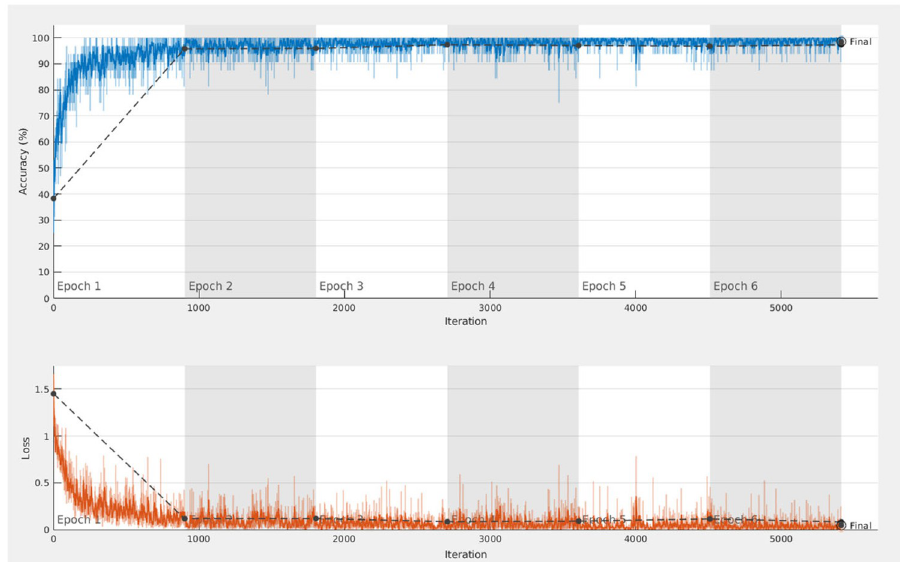
Fig 2. The training progress during fine-tuning as reported in [9]. The blue lines show smoothed and per iteration training accuracies in dark and light color variants, respectively. Similarly, the orange lines depict smoothed and per iteration training losses in dark and light color variants, respectively. The dashed dark gray lines linearly connect the validation accuracies and losses indicated by the dark gray circle markers.